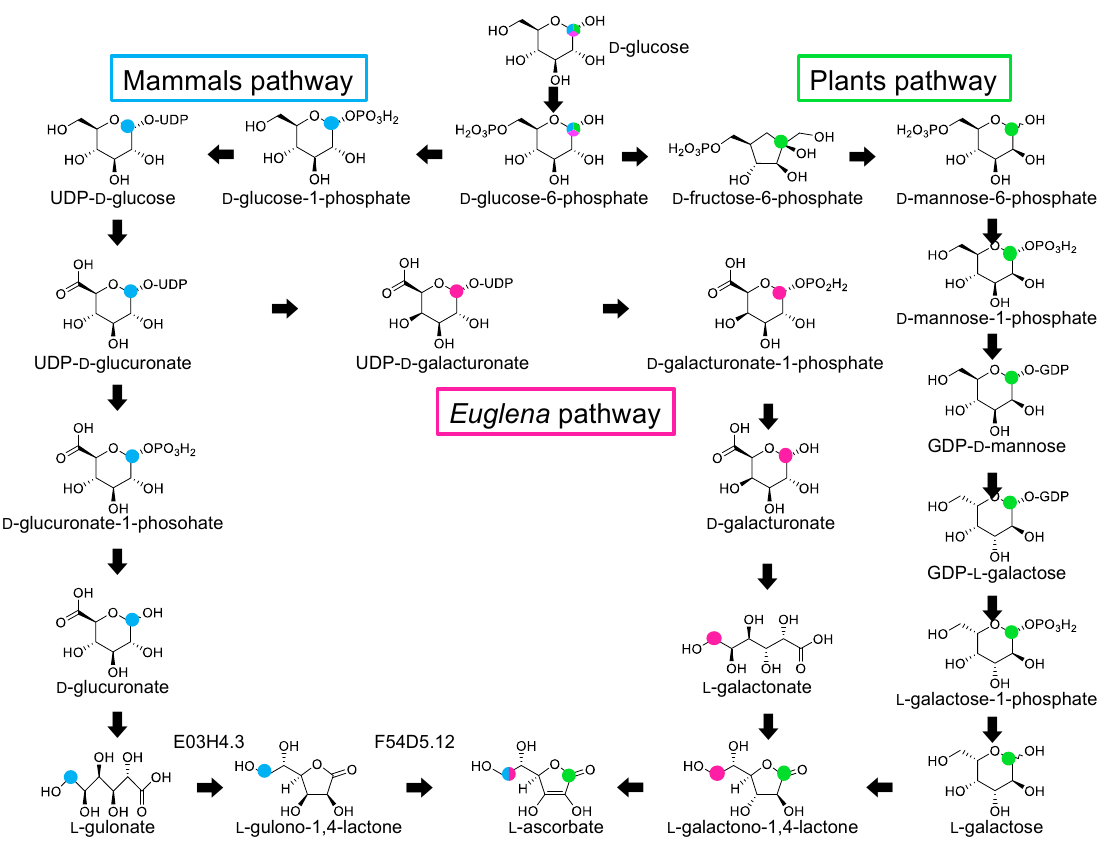
Figure 1. Ascorbate (AsA) biosynthetic pathways in mammals, plants, and Euglena . Overview of the major ascorbate pathways [20,21,28]. The mammalian and Euglena pathways involve carbon skeleton rearrangement, whereas the plant pathway does not.